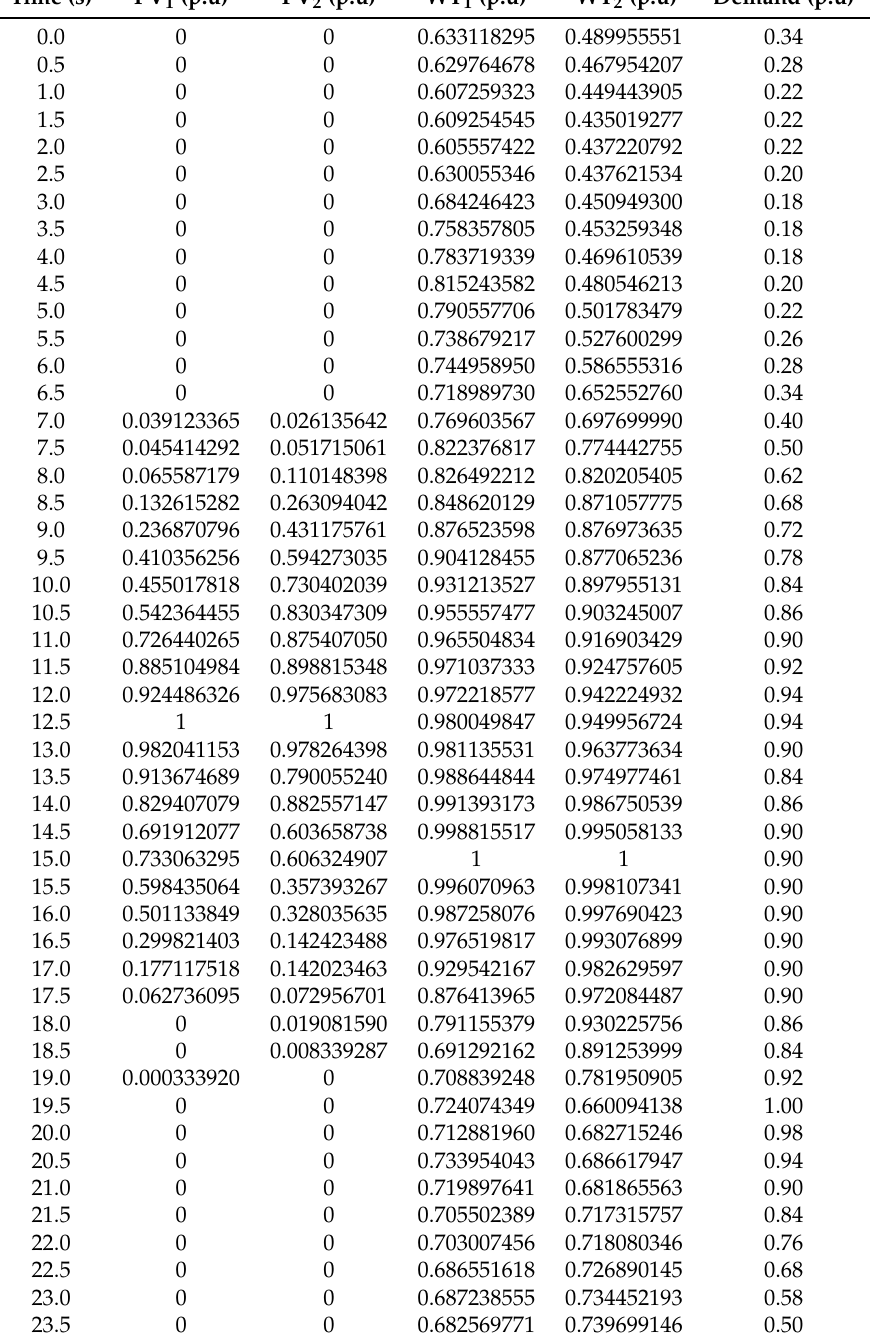
Table 2. Daily behavior of renewable generators and